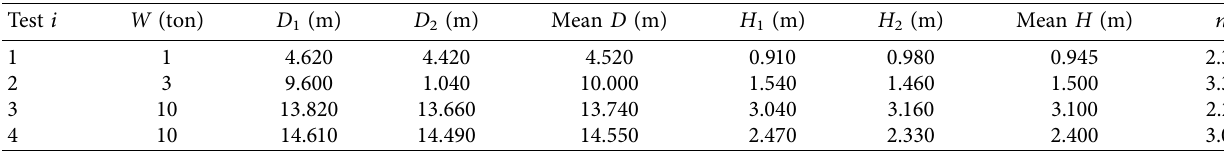
Table 1: Experimental crater dimensions.